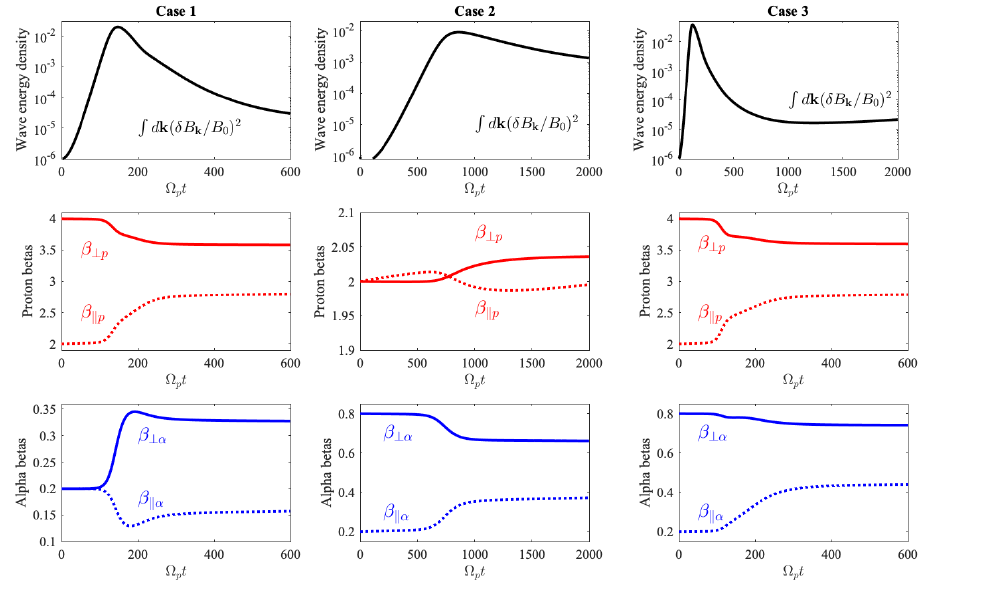
Figure 1. Quasilinear (QL) temporal variations for cases 1–3: the magnetic field energy density ( top row ), plasma beta parameters for protons ( middle row ), and alpha particles ( bottom row ). See text for